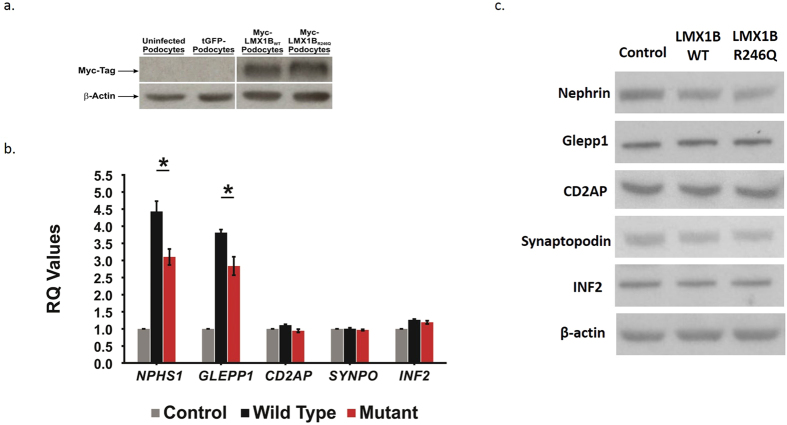
Effect of R246Q mutation on podocyte related gene transcription.(a) Western blot confirming expression of the viral transgene with the presence of the MYC tag in myc-LMX1BWT or myc-LMX1BR246Q infected immortalized human podocyte cells compared to uninfected and lentiviral control podocytes (top). β-actin was used as a loading control for all samples (bottom). Blots were cropped to exclude lanes that are not relevant to this paper, the uncropped blot is displayed in Supplementary Figure 6. (b) Graph depicting average Relative Quantity (RQ) values for NPHS1, GLEPP 1, INF2, and SYNPO in myc-LMX1BWT or myc-LMX1BR246Q cells (N ≥ 3). Error bars = SEM *p ≤ 0.05, **p ≤ 0.001 using t-test. (c) Immunoblotting showing reduced translation of nephrin (n = 7, p = 0.027) but not GLEPP1 (n = 4, p > 0.05), CD2AP (n = 3, p > 0.05), synaptopodin (n = 3, p > 0.05) and INF2 (n = 3, p > 0.05) in myc-LMX1BR246Q podocytes compared to myc-LMX1BWTexpressing cells. β-actin was used as a loading control for all samples and unedited blots are shown in Supplementary Figure 6.